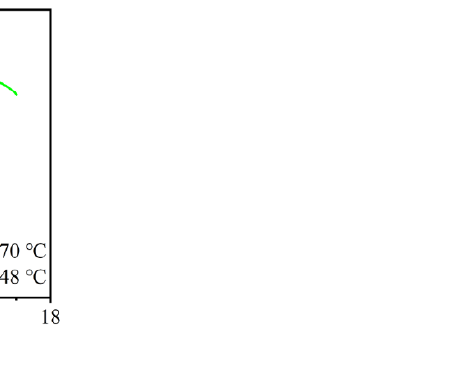
Figure 11. Engineering stress – strain curves of tested steel under different heat treatment processes.